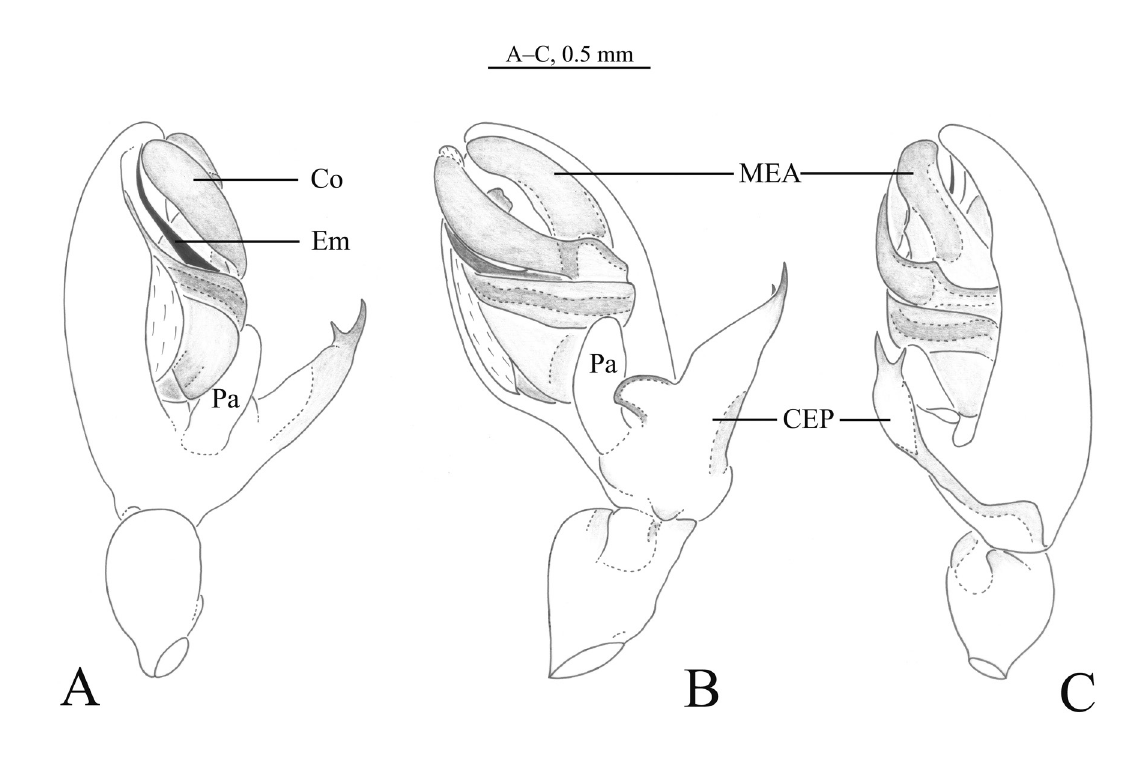
Fig. 8. Meta gyirong sp. nov., ♂, holotype (SWUC-T-TEg-04-01). A . Left palp, prolateral view. B . Same, ventral view. C . Same, retrolateral